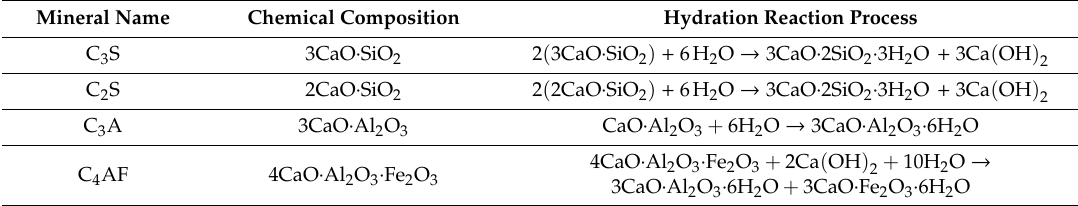
Table 6. Hydrolysis hydration of